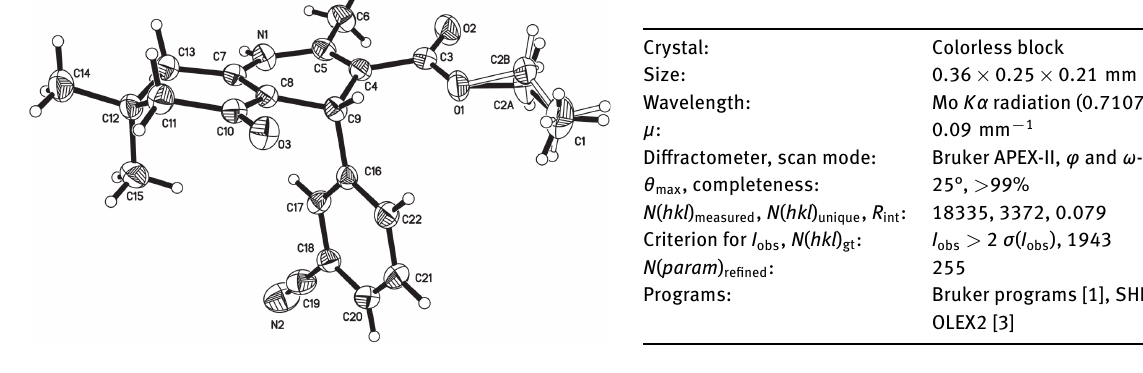
Table 2: Fractional atomic coordinates and isotropic or equivalent isotropic displacement parameters (Å 2